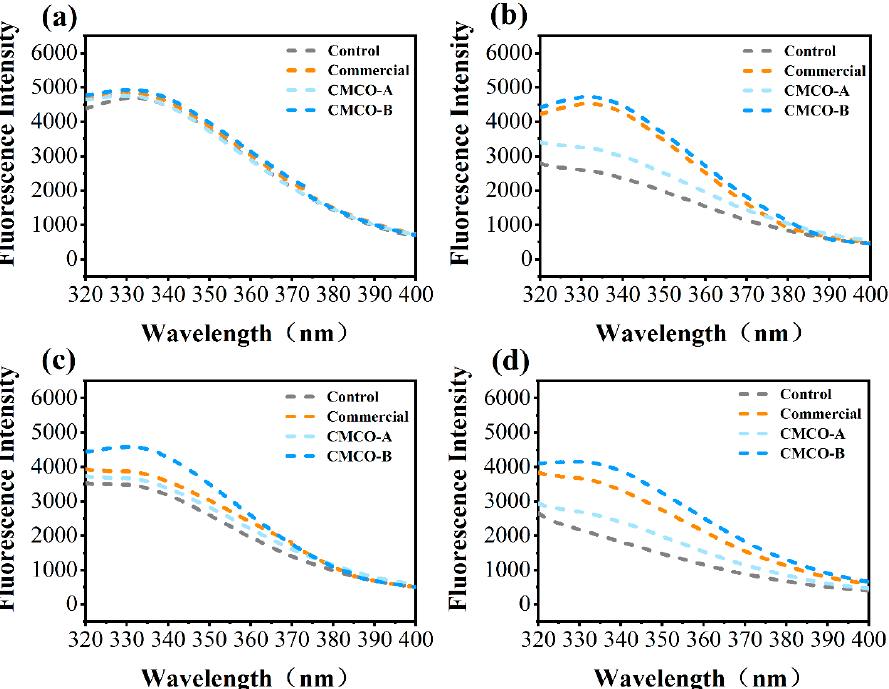
Figure 3. Effects of CMCO on fluorescence intensity of MP at different storage time: ( a ) day 0, ( b ) day 15, ( c ) day 30, and ( d ) day 60.